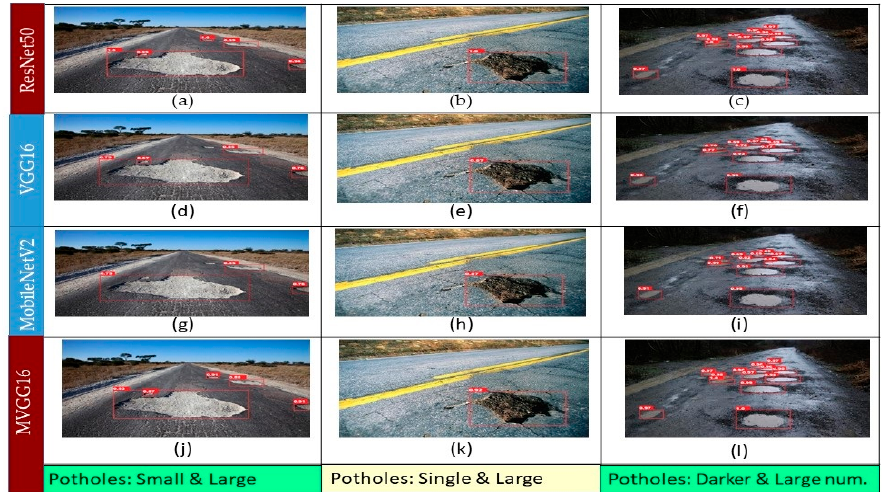
Figure 8. Detection results using Faster R-CNN with different backbones: ( a – c ) ResNet50; ( d – f ) VGG16; ( g – i ) MobileNetV2; ( j – l ) MVGG16.